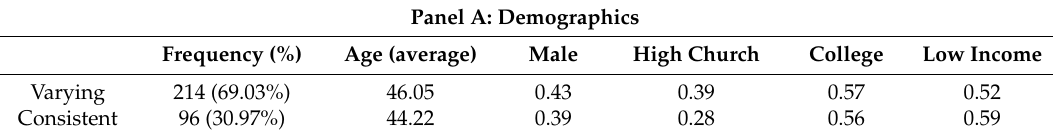
Table 6. Summary of varying and consistent givers’